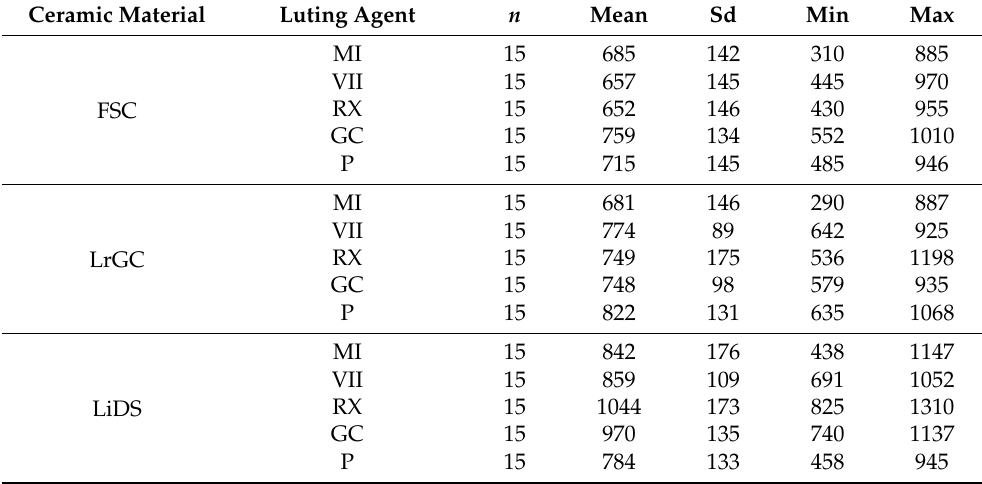
Table 3. Retentive strength (mean, minimum, maximum, SD in N) divided by ceramic material and luting